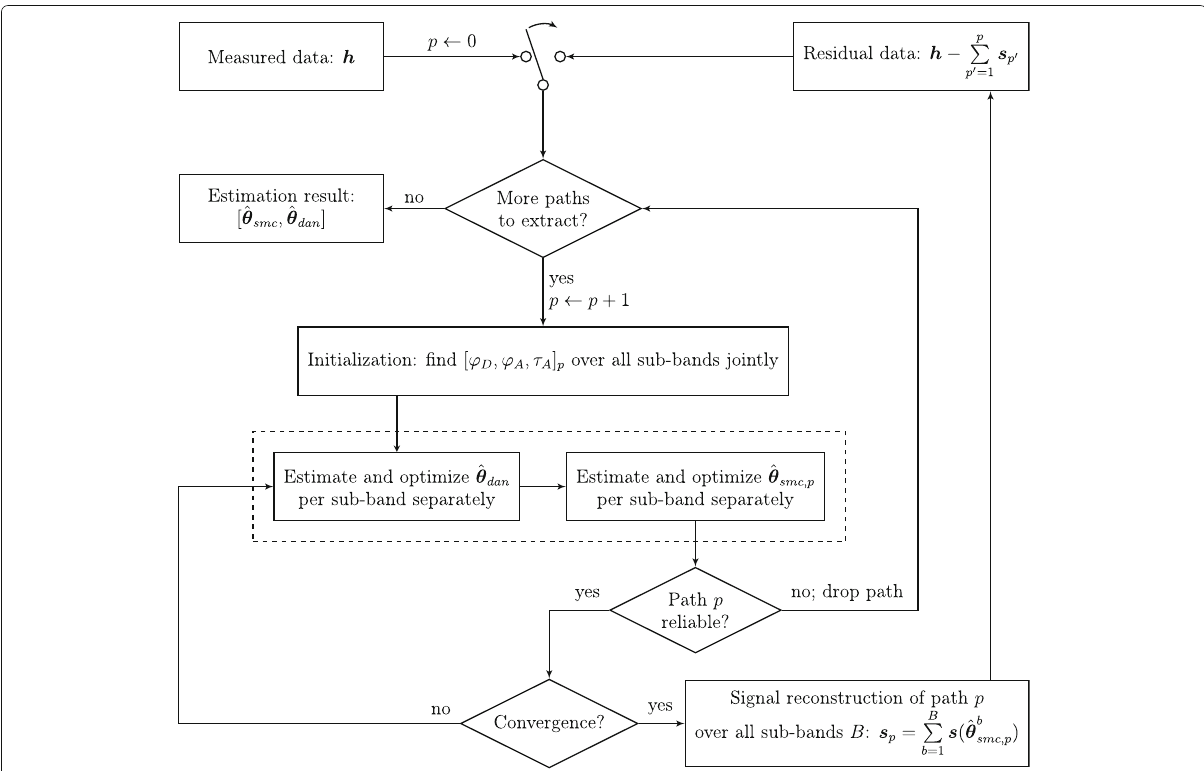
Fig. 1 Flowchart of the UWB-RiMAX multipath estimation algorithm. In the first iteration, the input data will be the measured channel h . The one-time switch at the top will ensure that subsequent iterations of the algorithm will make use of the residual channel as input data